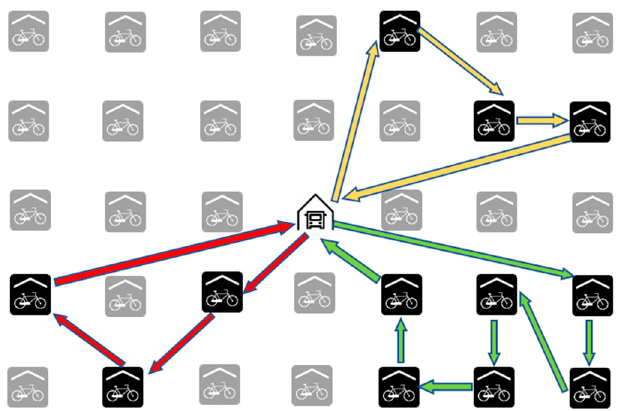
Figure 5. General representation of the routing scheme around a depot.